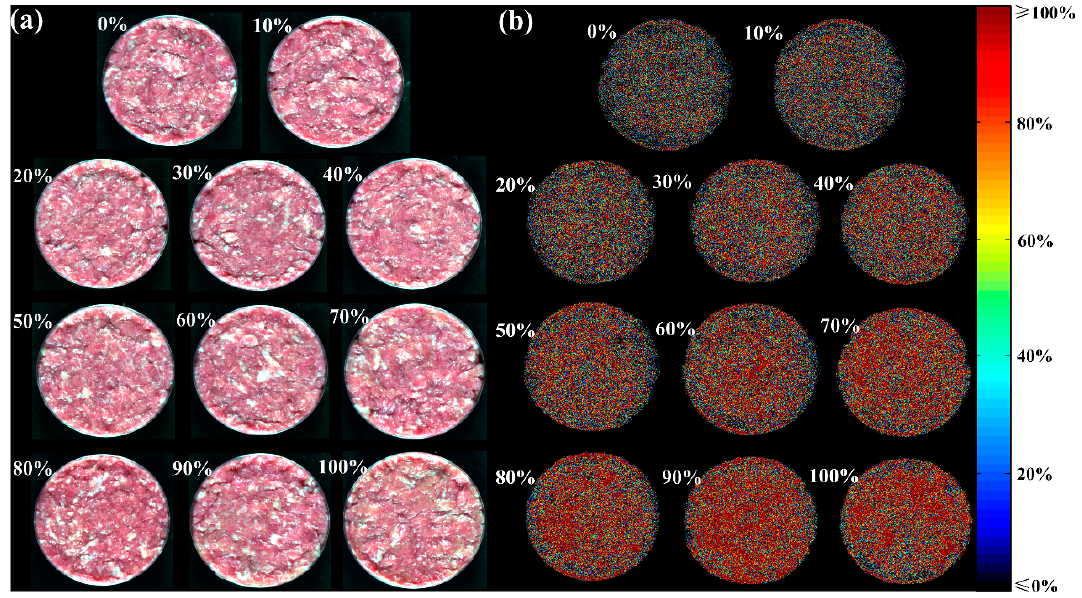
Figure 6. Distribution maps of jowl meat adulteration in pork at pixel level. ( a ) False color images, ( b ) Distribution maps.